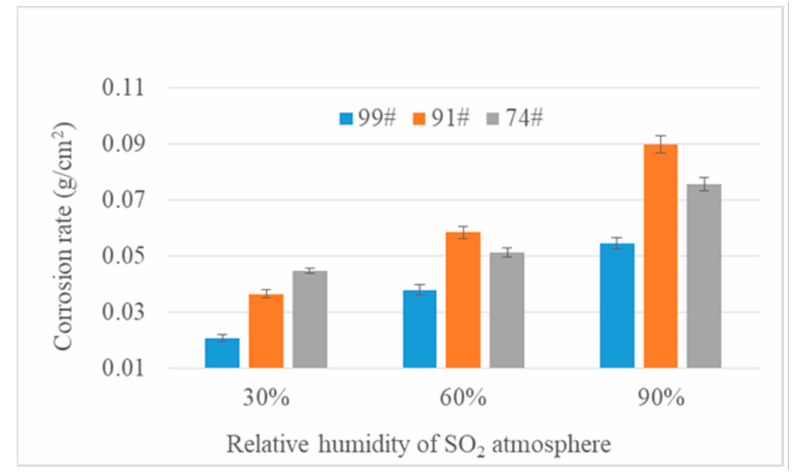
Figure 3. Corrosion rate of various gold leaf samples in a SO 2 atmosphere over six weeks.